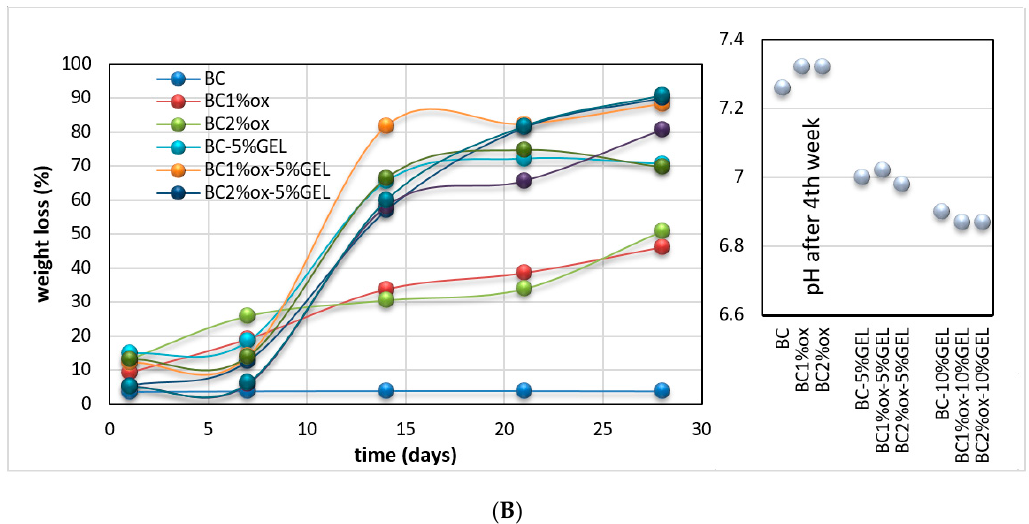
Figure 6. ( A ) Swelling % at equilibrium and ( B ) weight loss % after 1–28 days of incubation with scatter data of pH obtained from respective incubation solutions after the 28th day of incubation (b). Photographs were taken on dry and fully swollen BC–10%GEL membrane, with simplified demonstrations on its handling (stretch and bend). The results presented are mean values ( n = 5; SD < 0.1 for weight loss and 0.01 for pH).